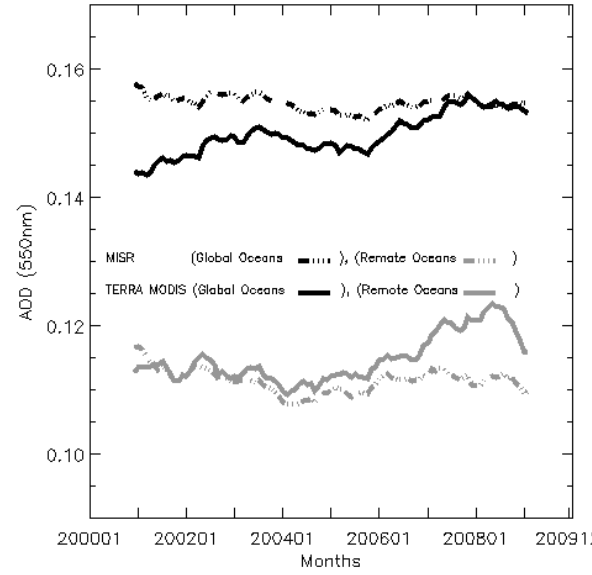
Fig. 6. Boxcar analysis for the monthly mean Terra MODIS (solid line), and MISR (dot dash line) over water aerosol products for both global oceans (black) and the RO region (grey). The boxcar window size is set to ± 11 months. Only collocated Terra MODIS and MISR AOD data were used in the